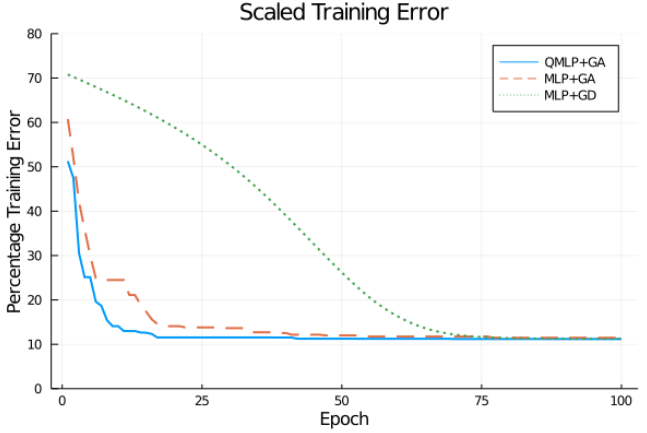
Figure 6. The training set mean absolute error for each network.